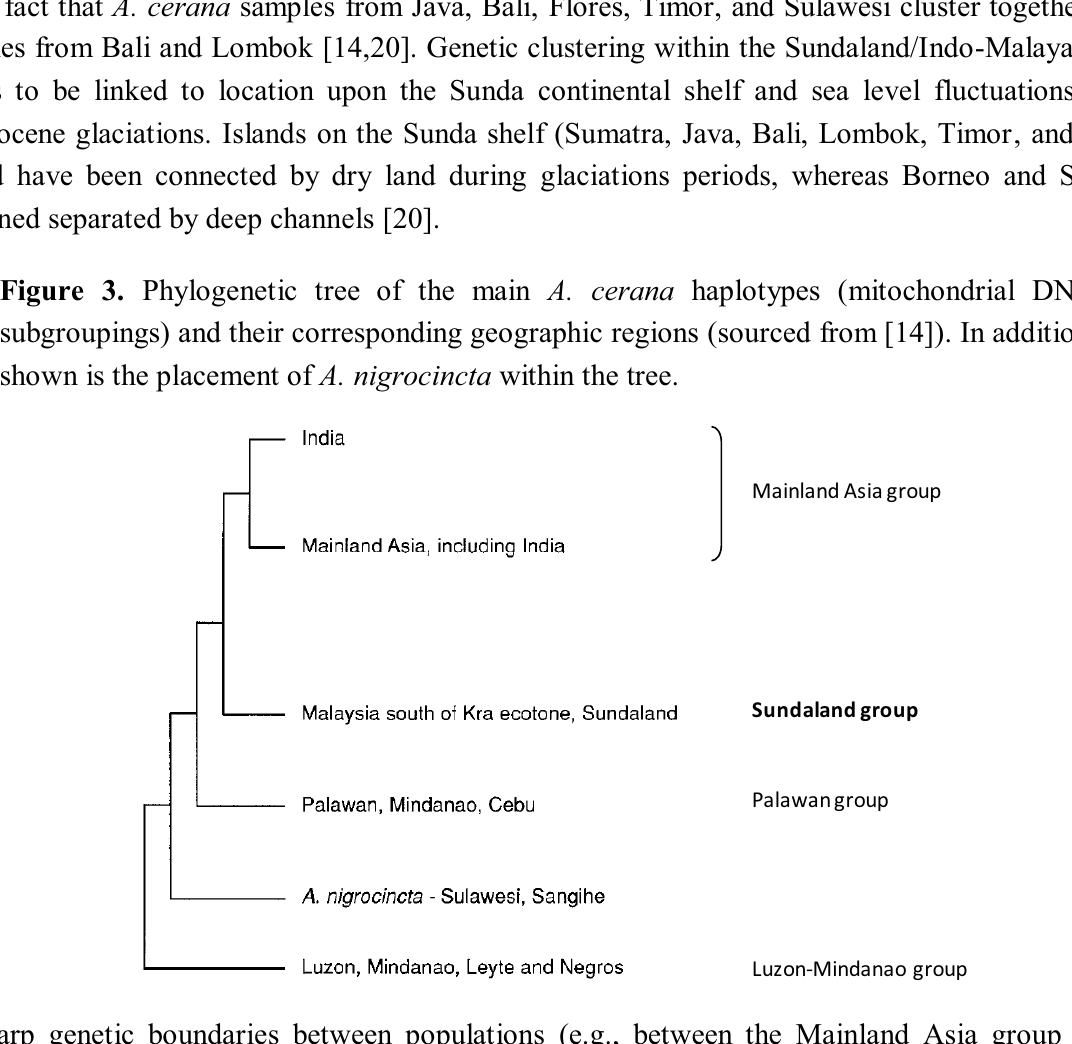
Figure 3. Phylogenetic tree of the main A. cerana haplotypes (mitochondrial DNA subgroupings) and their corresponding geographic regions (sourced from [14]). In addition, shown is the placement of A. nigrocincta within the tree.